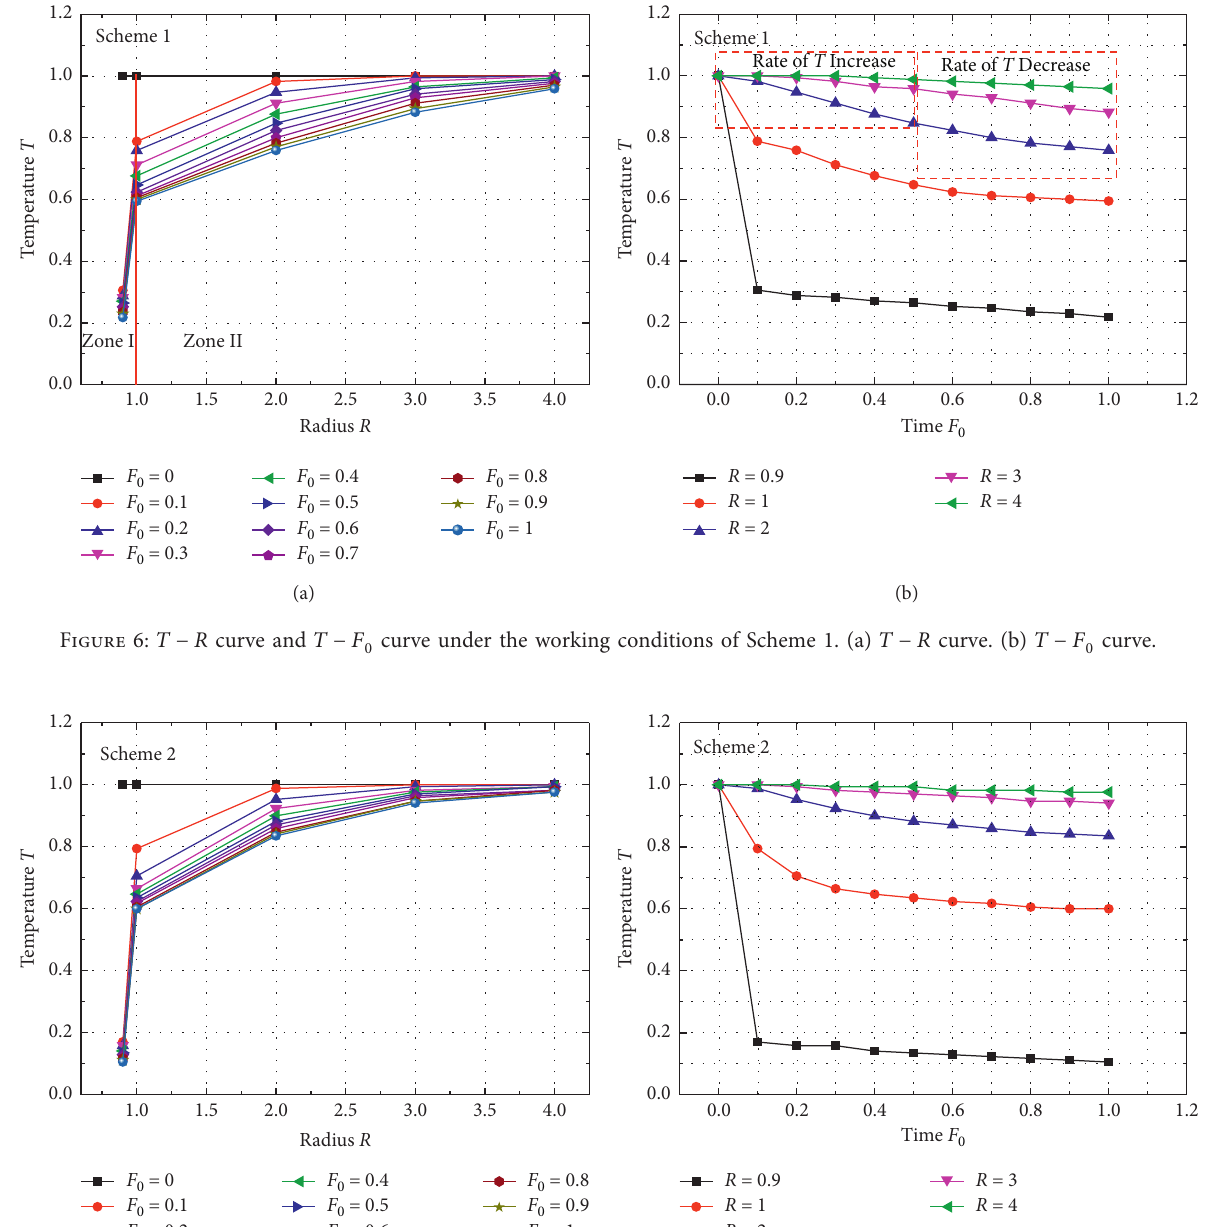
curve under the working conditions of Scheme 2. (a) T − R curve. (b) T − F 0